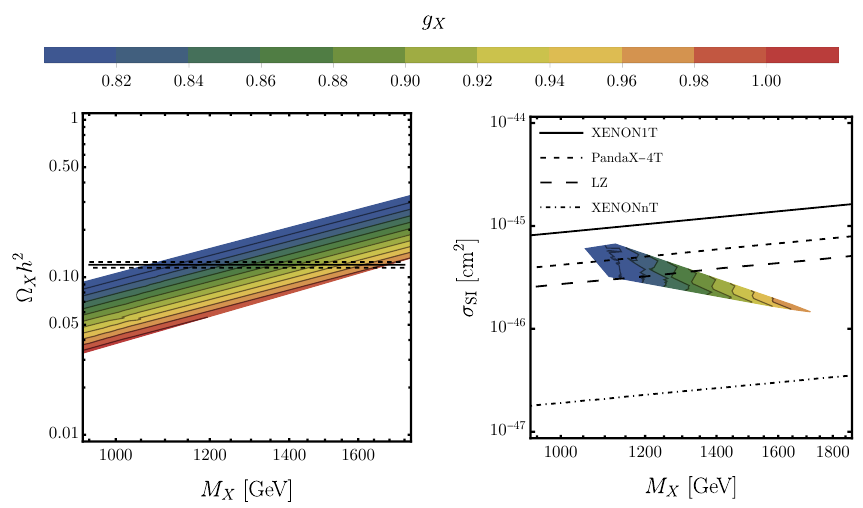
Figure 16 . Left: dark matter relic abundance Ω X h 2 with colour changing according to the value of the gauge coupling g . The black lines correspond to the measured value Ω 2 = 0 . 120 ± 5 σ . X DM h Right: the spin-independent dark matter-nucleon cross section. The coloured region corresponds to points that reproduce the measured relic abundance within 5 σ . The lines represent the exclusion limit from the XENON1T 2018 [216] (solid), PandaX-4T 2021 [217] (dashed), LZ 2022 [218] (large dashed) and the scheduled XENONnT [219] (dot dashed)